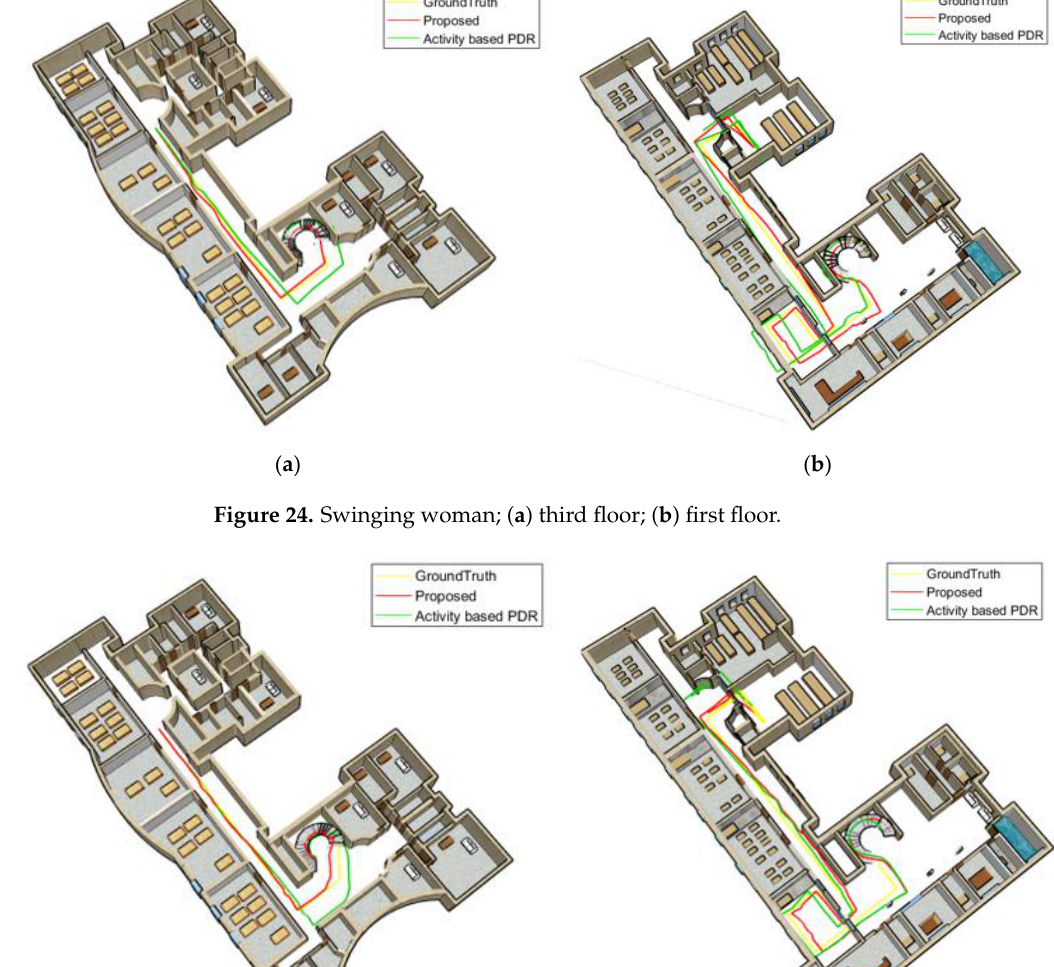
Figure 25. Swinging man; ( a ) third floor; ( b ) first floor.